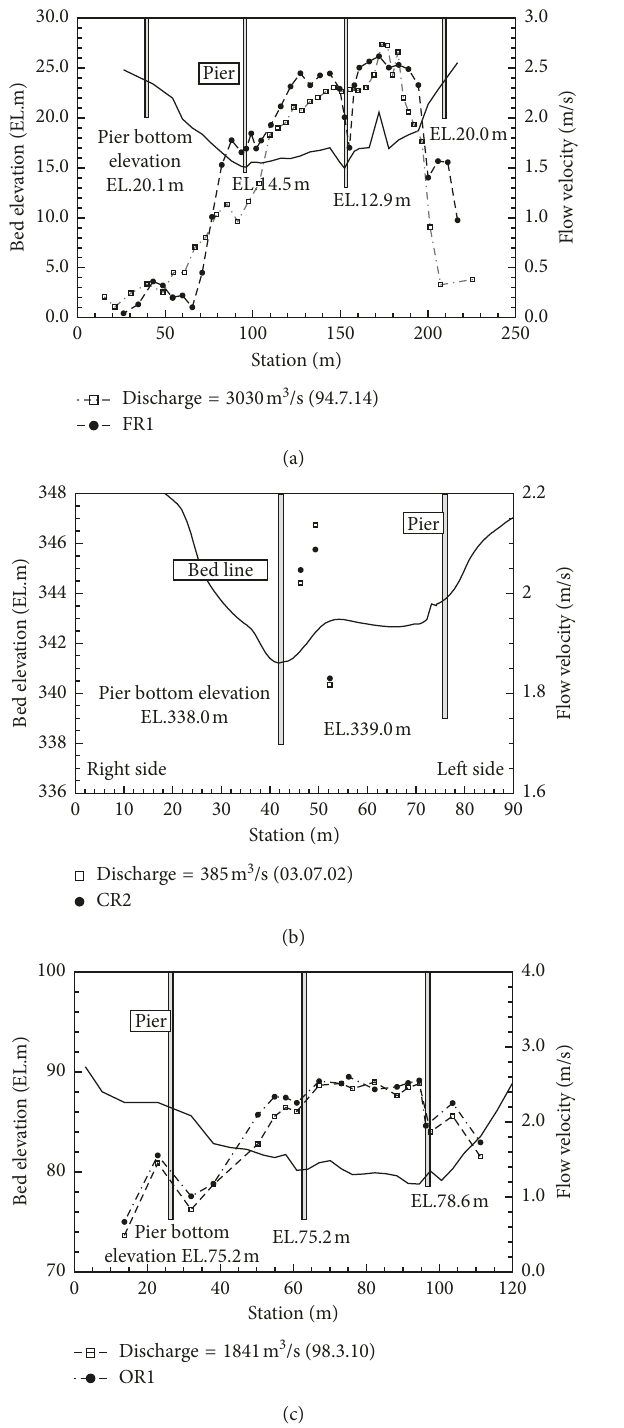
Figure 6: Velocity comparison between laboratory and field measurements for (a) FR1, (b) CR2, and (c) OR1.